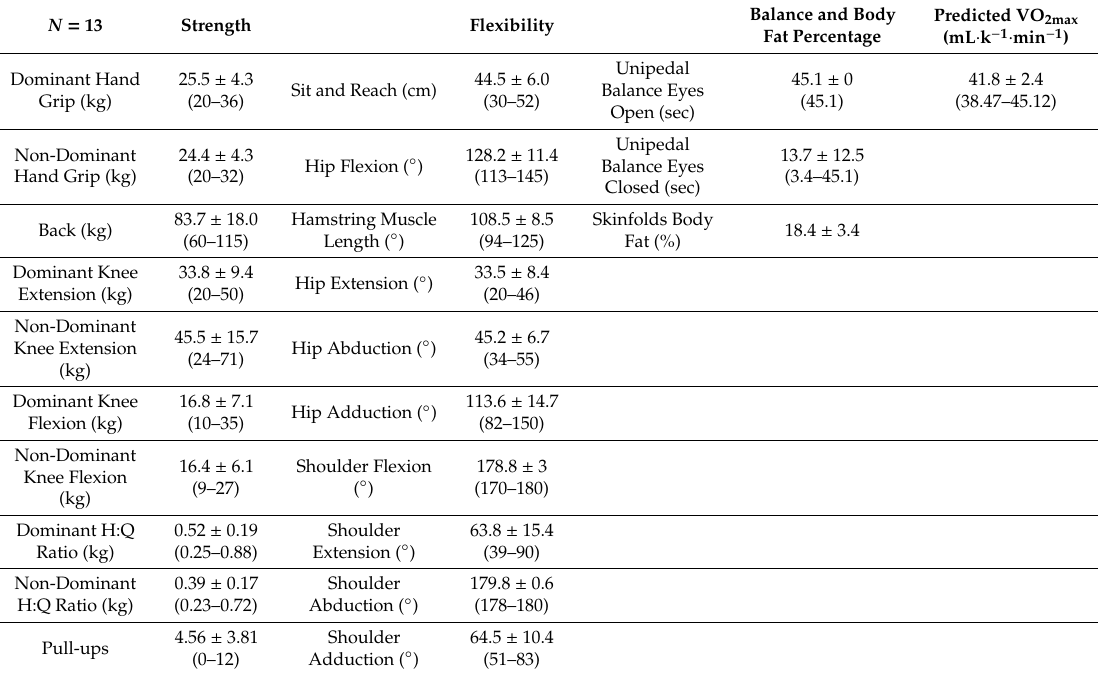
Table 1. Physiological Profile Means ± SD and (Ranges) of Recreational Aerial